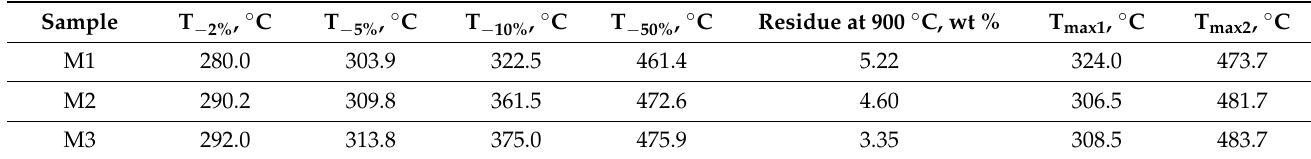
Figure 8. Plots of ( a ) mass change and ( b ) differential thermogravimetric curves of wastes. Table 3. Temperatures of 2, 5, 10, and 50% mass losses, values of residue at 900 ◦ C, and temperature positions of peaks on differential thermogravimetric curves determined for M1-M3